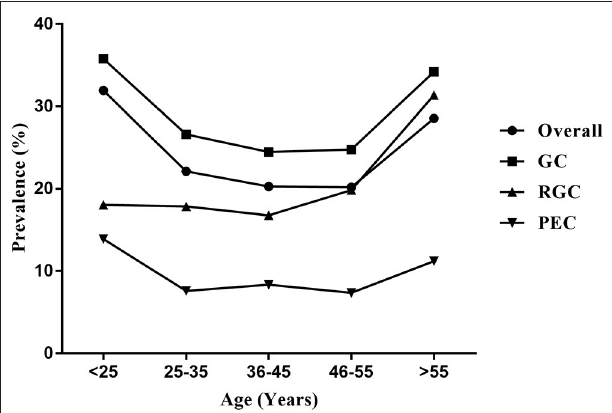
FIGURE 3 | Age-specific prevalence of HPV infection in the outpatient-based population. Overall, total HPV-positive cases; GC, gynecological outpatients; RGC, reproductive gynecological outpatients; PEC, physically examined